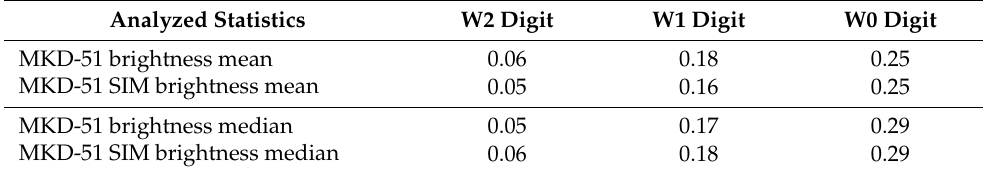
Table 1. Comparison of multiplexed digits images